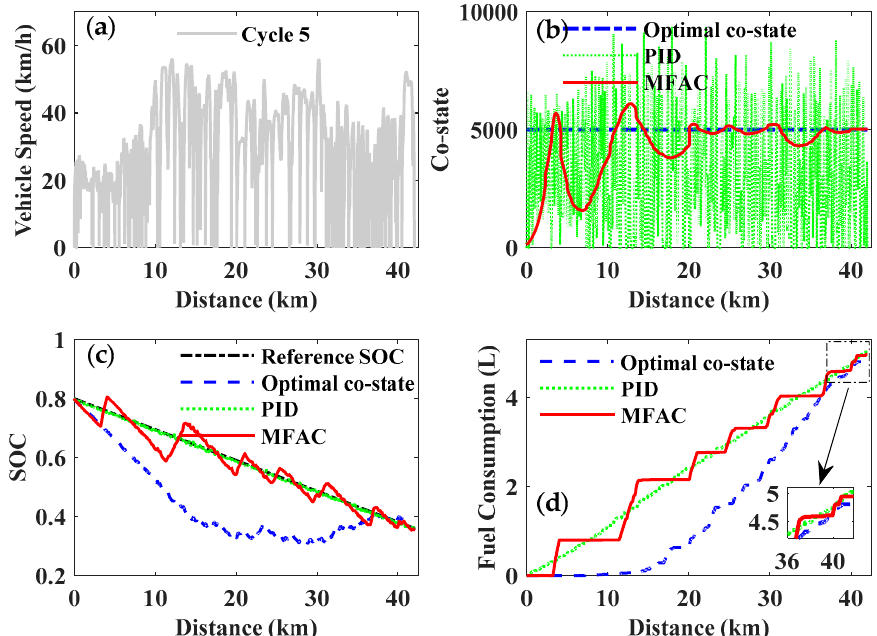
Figure 22. The simulation results of driving Cycle 5. ( a ) Driving cycle; ( b ) Co-state; ( c ) SOC; ( d ) Fuel consumption.